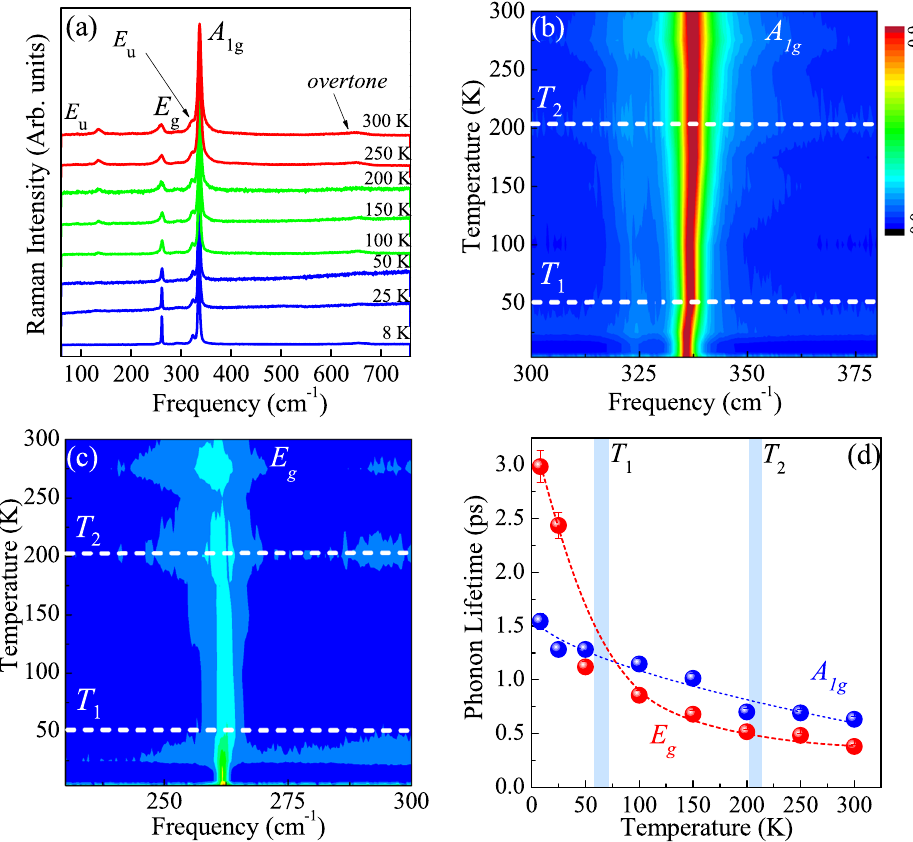
Fig. 4 Variable-temperature Raman spectroscopy and associated phonon lifetime analysis of 1T-HfS 2 . a Raman scattering response of 1T- HfS 2 as a function of temperature. The mode symmetries are labeled, and the spectra are offset for clarity. b Contour plot showing subtle changes in the A 1 g mode as a function of temperature. Weak structural distortions at T 1 and T 2 are indicated. The color scale gives relative intensity. c Contour plot showing the development of the E g mode with temperature. d Phonon lifetime of two Raman-active modes as a function of temperature. Data are available in Supplementary Information. T 1 and T 2 are denoted by the color scheme in ( a ) and the vertical blue lines in ( d